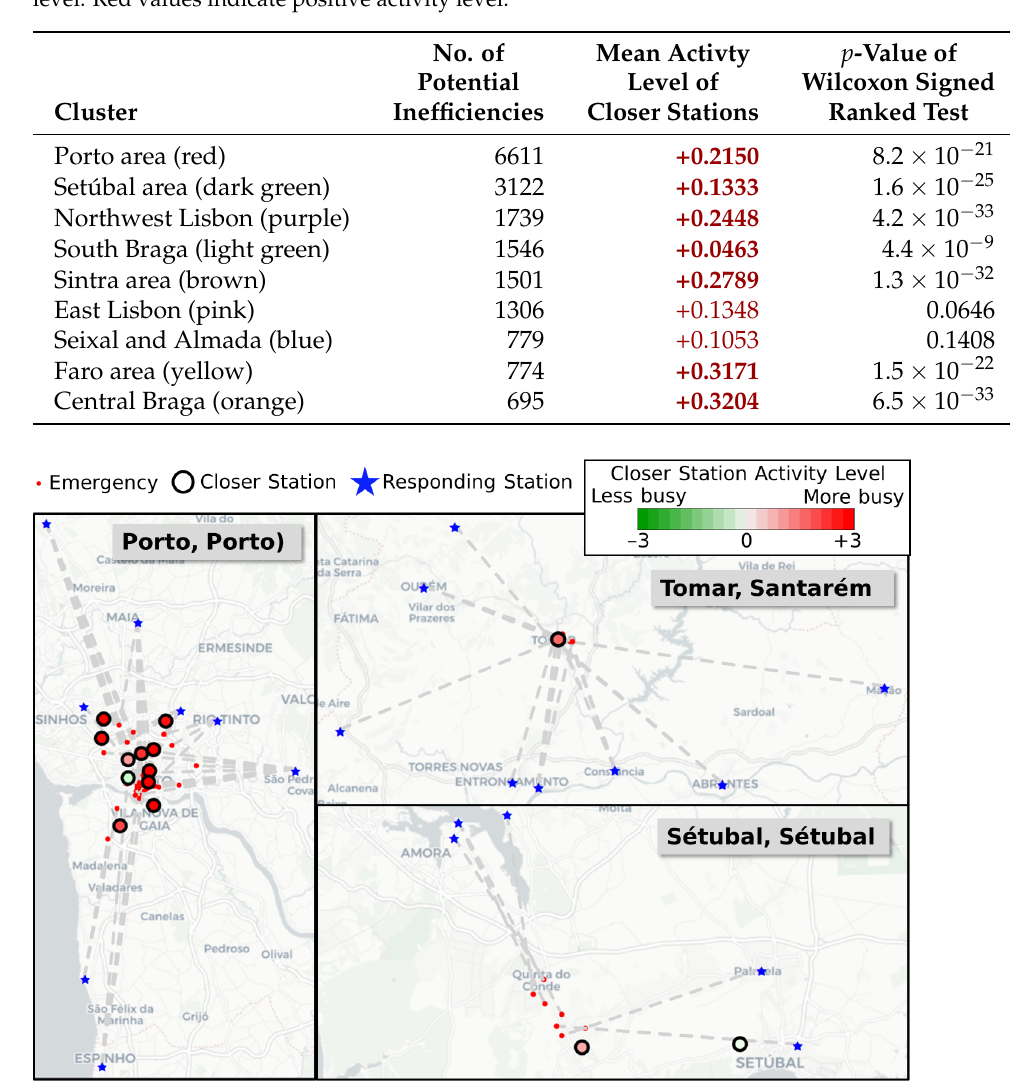
Table 2. Potential inefficiency statistics per area cluster. Bold values indicate significance at a 0.01 level. Red values indicate positive activity level.